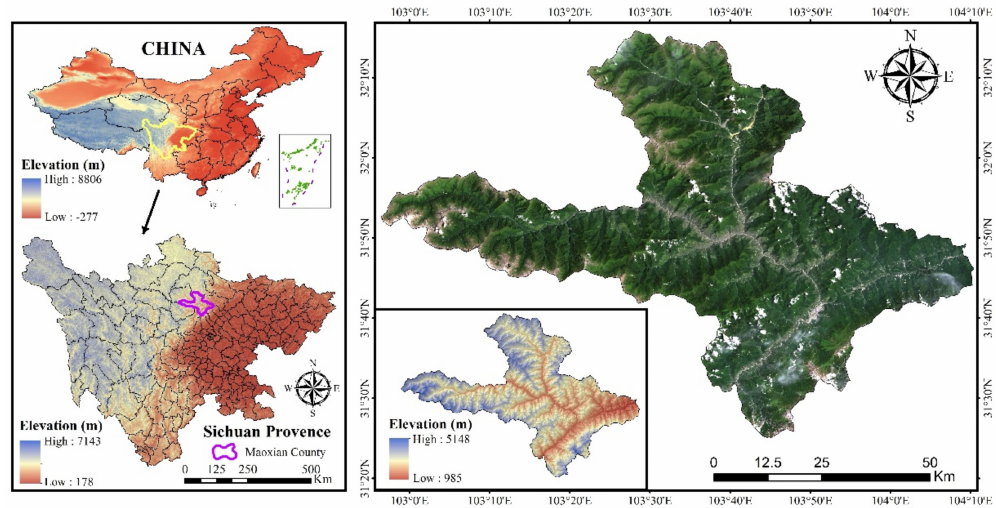
Figure 1. Geographic location of the study